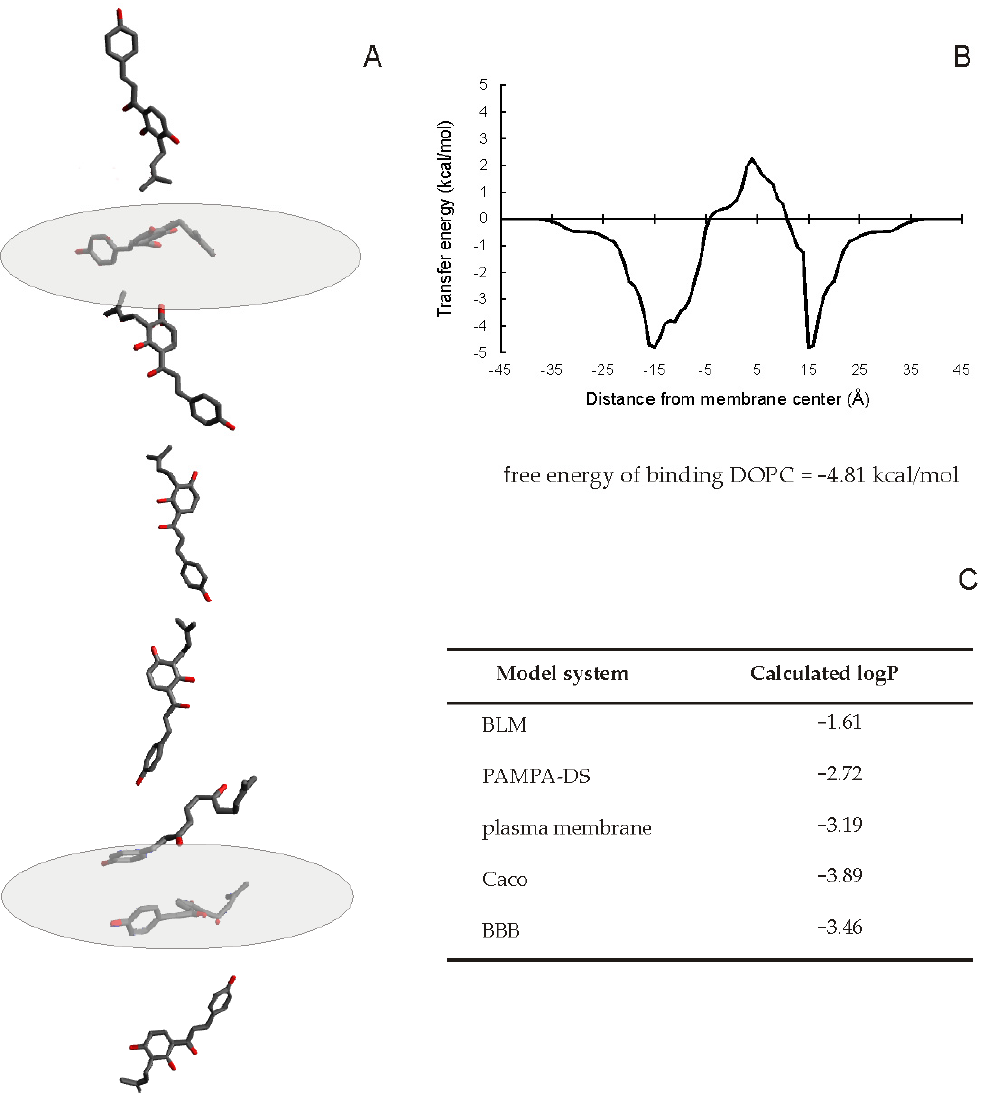
Figure 7. Spatial positions, optimized orientations ( A ), and transfer energy profile ( B ) calculated for IBC molecule as it crosses the DOPC bilayer; permeability coefficients calculated for various membrane models ( C ). Calculations s were performed by the publicly available PerMM web server using the “global rotational optimization” option.